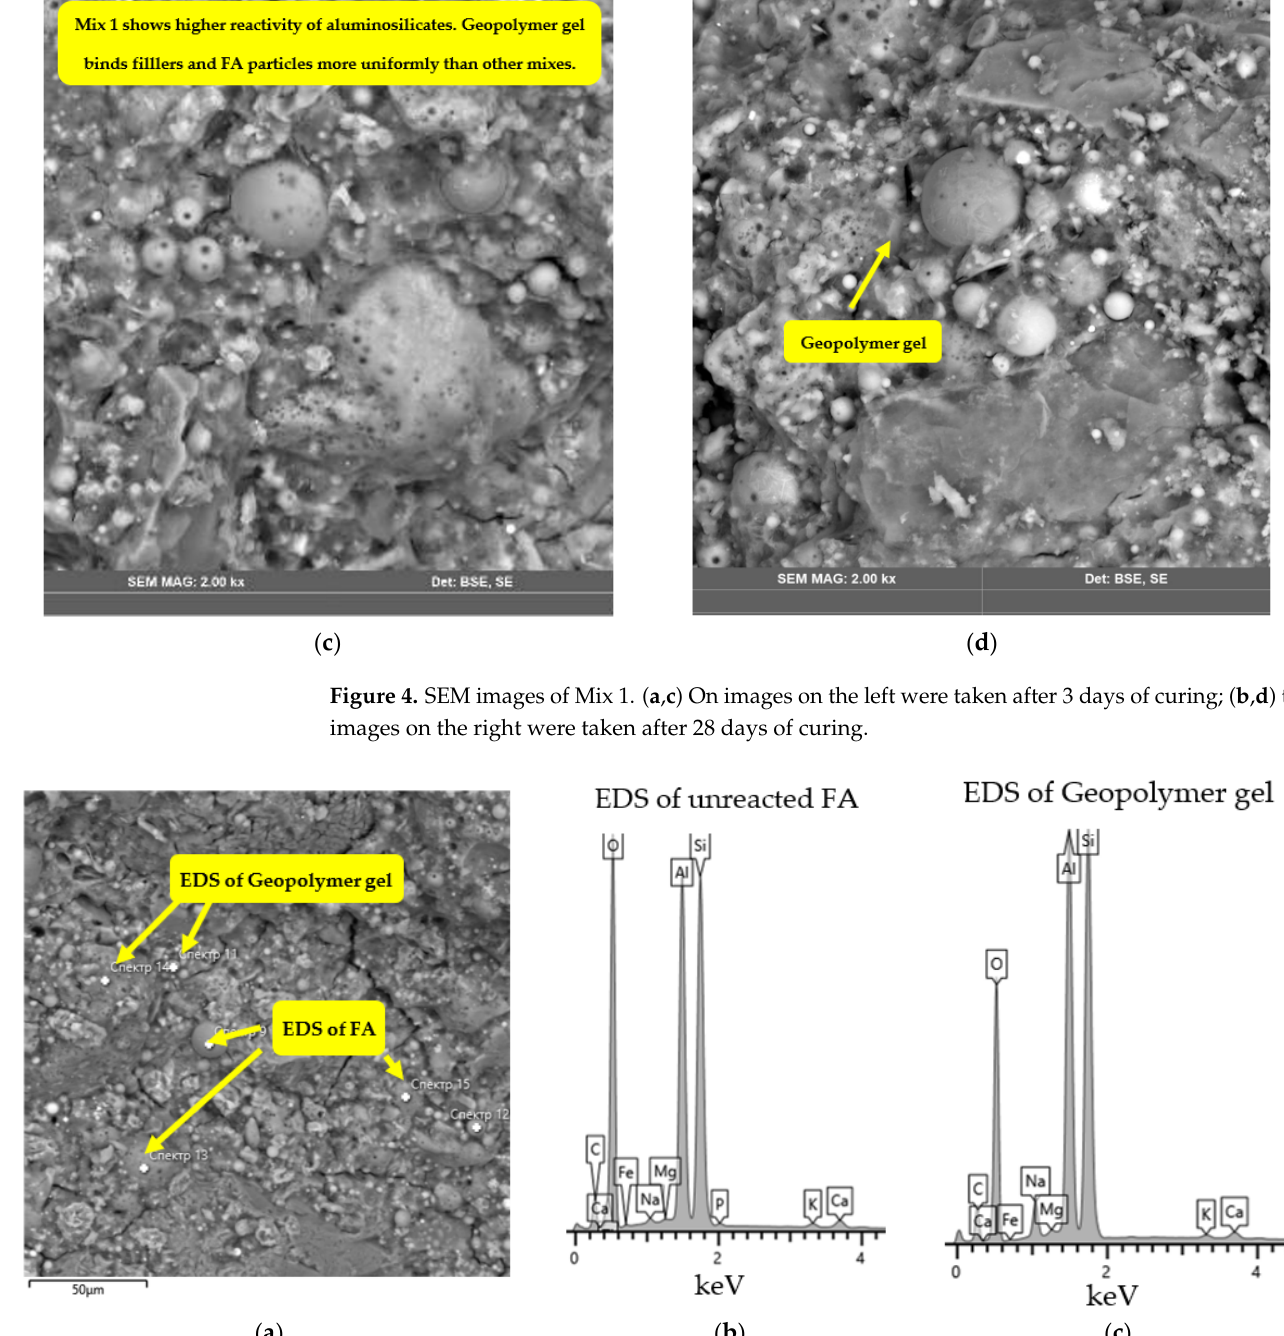
Figure 5. SEM image ( a ); EDS data of developed geopolymer concrete (Mix 1) where ( b ) is the EDS of unreacted FA, and ( c ) is the EDS of geopolymer gel.